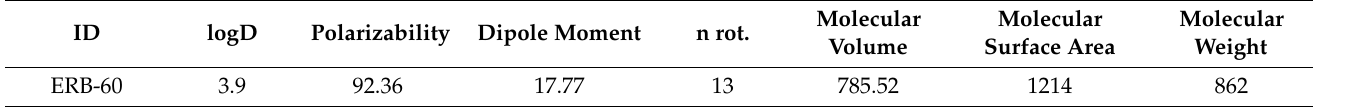
Table 1. Physicochemical properties of ERB-60 calculated using ChemAxon. The data calculated (at pH 7.4) include: logD, polarizability, dipole moment (debye), number of rotatable bonds, volume (Å 3 ), molecular surface area (Å 3 ), and molecular weight (g/mol). logD Polarizability Dipole Moment n rot.